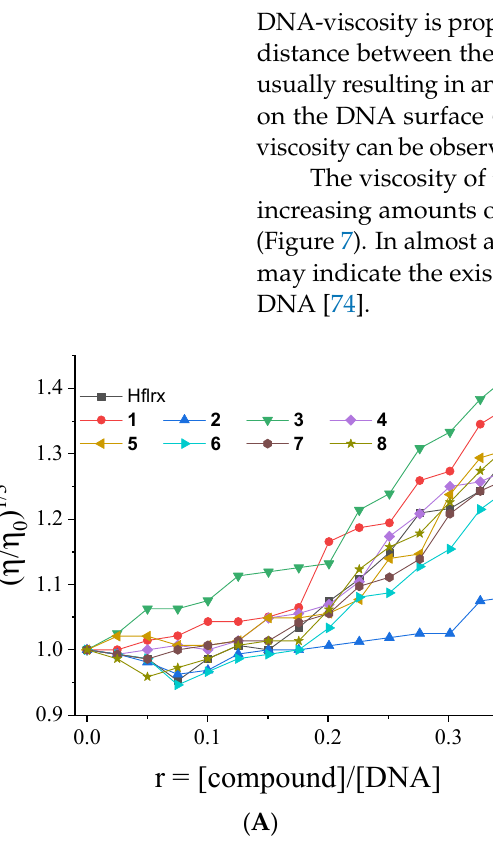
Table 7. Cathodic and anodic potentials (in mV) for the redox couple M(II)/M(I) of the fleroxacin complexes in a 1:2 DMSO/buffer solution in the absence or presence of CT DNA. Ratio of equilib- rium binding constants, K r /K ox .